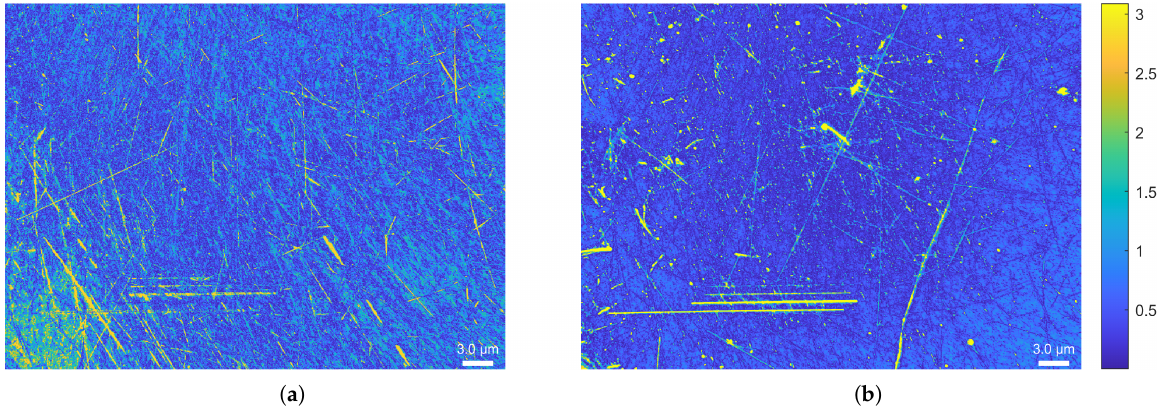
Figure 5. Saliency maps derived from an RTI acquisition with an exposure time ( E t ) of 125 ms on a polished watch dial with micro-scratches of different amplitudes: ( a ) Saliency from geometric descriptors and ( b ) Saliency from statistic